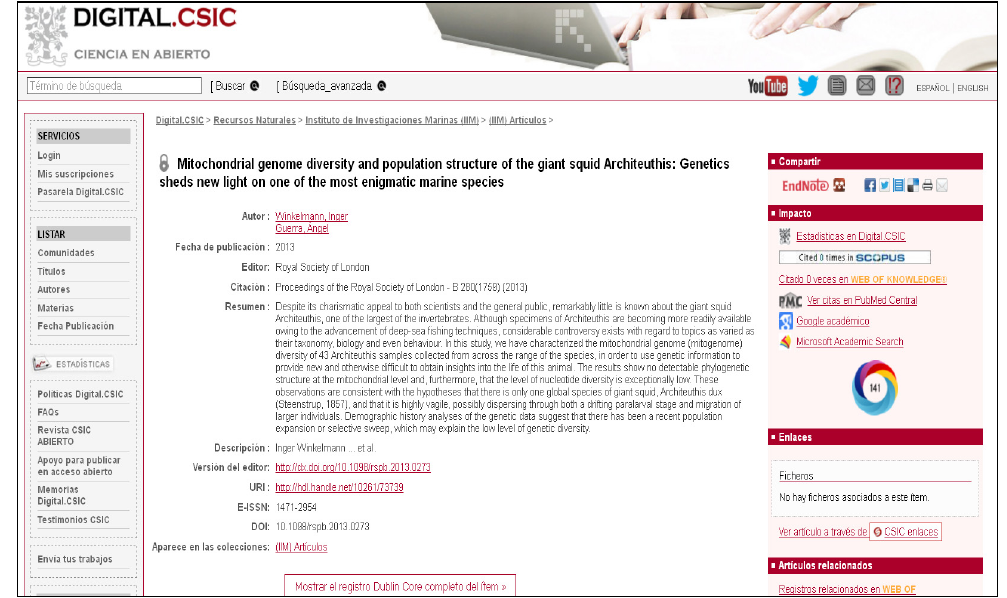
Figure 8. Altmetric API at work in DIGITAL.CSIC. Article Mithocondrial genome diversity and population structure of the giant squid Architeuthis: Genetics sheds new light on one of the most enigmatic marine species as an example with metrics on immediate